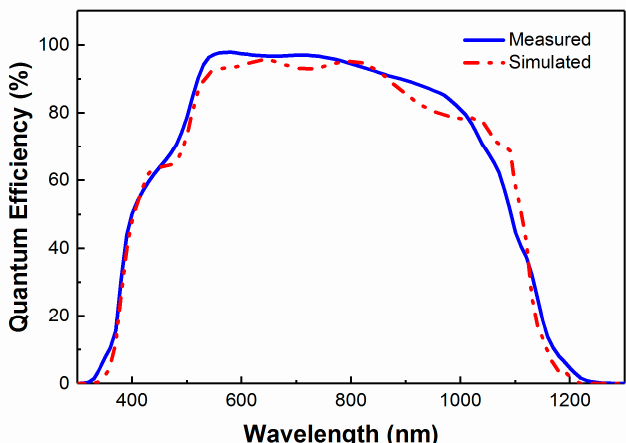
Figure 4. Comparison of the measured and optically simulated QE spectra for the CIGS solar cell characterized by SE in Figure 1.